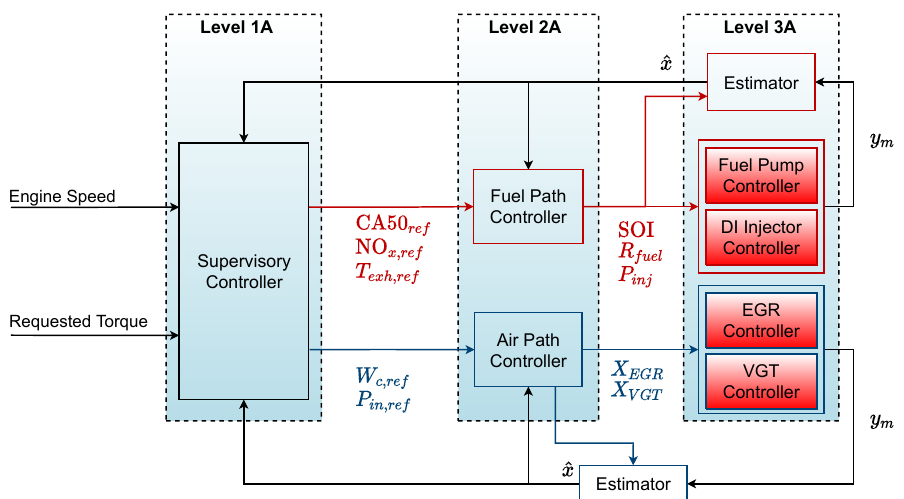
Figure 5. An MPC framework to regulate the engine-out NO x and PM emissions of a turbocharged CI engine. This includes three-level hierarchy ICE control based on topology I. W c : Compressor air mass flow rate, P in : Intake manifold pressure, T exh : Exhaust manifold temperature, R fuel : Fuel ratio (pilot/total), p inj : Fuel rail pressure, X EGR : EGR rate, X VGT : VGT rate, y m : measured output, and ˆ x : estimated states (based on [30]).